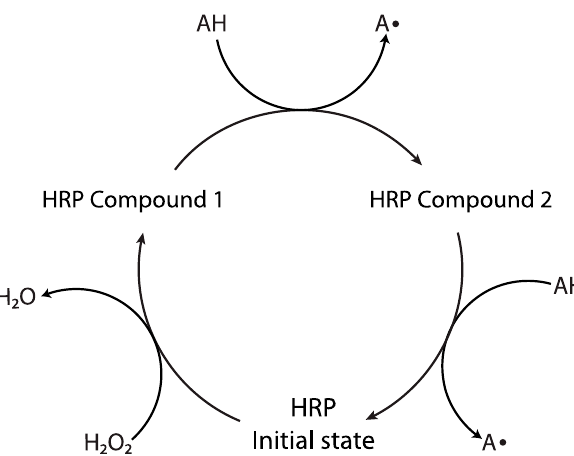
Figure 2. Horseradish peroxidase (HRP) catalyzes the reduction of hydrogen peroxide to water by oxidizing two equivalents of a hydrogen-donating mediator AH. HRP compounds 1 and 2 are oxidized forms of HRP that are each capable of oxidizing the mediator AH, yielding radicals that may be utilized for the initiation of radical-mediated polymerization [21–23]. Arrows show reaction direction.